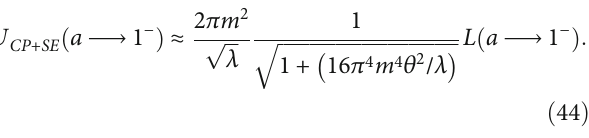
Figure 2: This is a parametric plot of L ð a Þ v/s a . The values chosen are m = 1 , λ = 4 π 2 . The red and blue lines are plots for θ = 0 : 2 and θ = 0 : 3 , respectively; the cyan line stands for θ = 0 : 75 . Note that for the latter case, the plot becomes degenerate of intermediate values of the parameter a , though the predictions for extreme values of L remain true. We will stick to the fi rst two values for our numerical